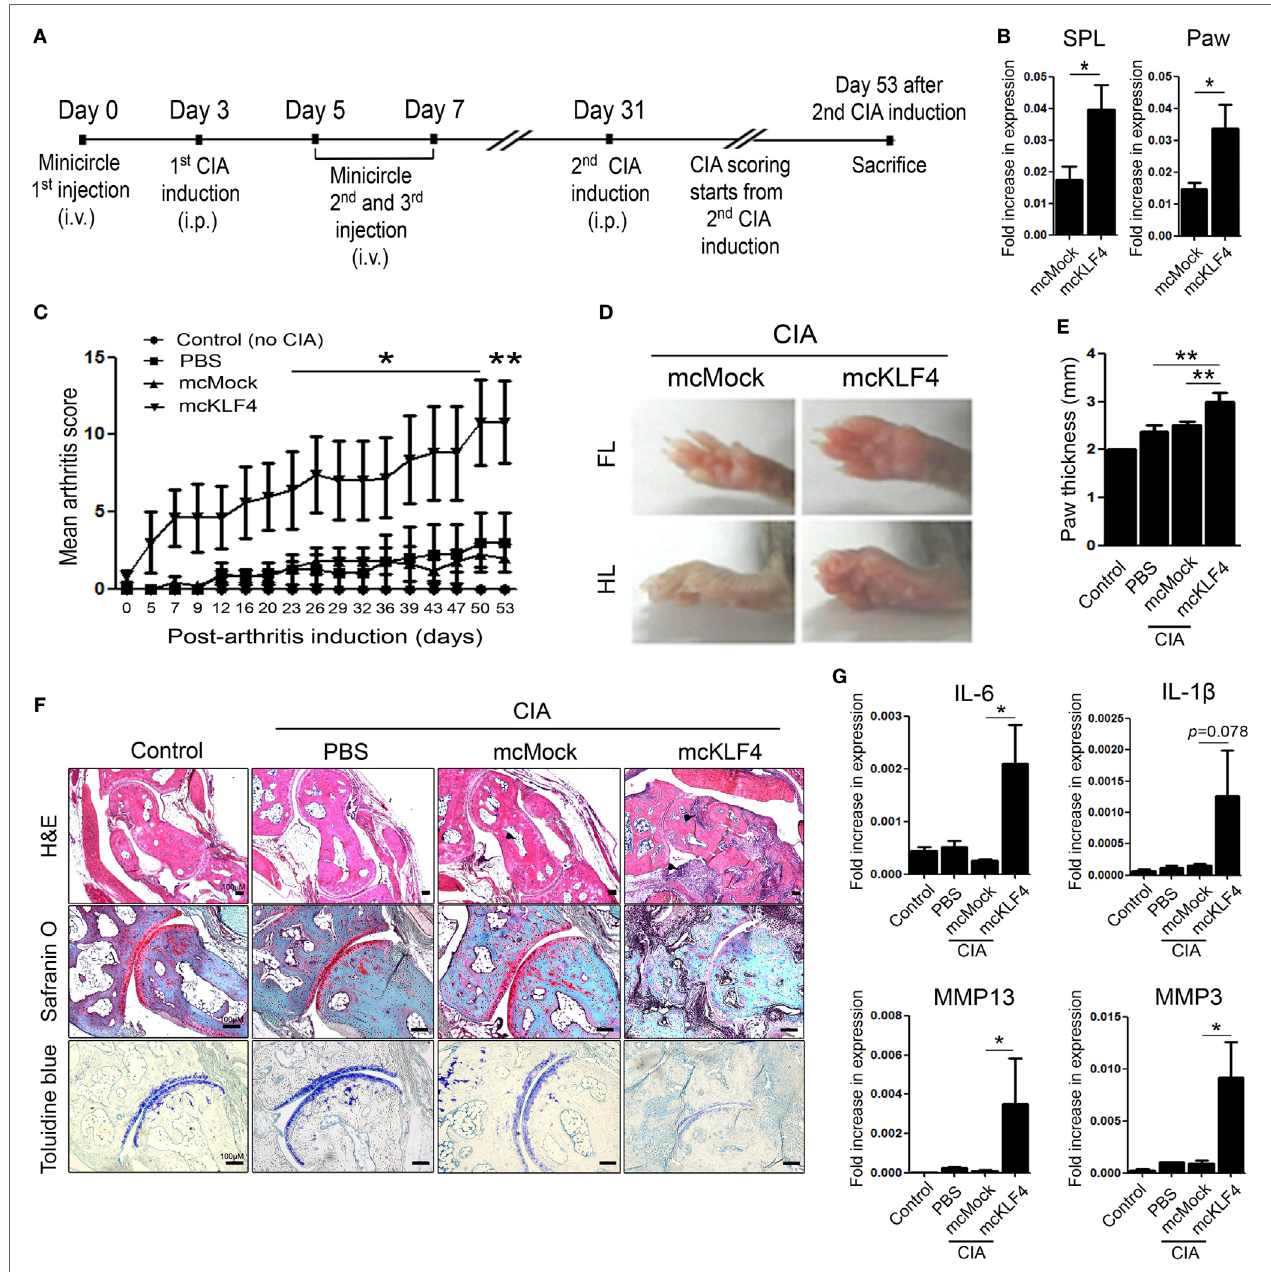
FigUre 3 | Overexpression of Kruppel-like factor (KLF) 4 in collagen-induced arthritis (CIA) mice results in severe autoimmune arthritis. (a) Experimental induction of CIA by intravenous (i.v.) injection of minicircle vectors. (b) Expression of KLF4 mRNA in splenocytes (SPL) and paw cells from minicircle Mock vector (mcMock)- and minicircle KLF4 vector (mcKLF4)-injected mouse ( n = 3). (c) Mean arthritis scores for control mice (not induced by collagen) ( n = 4), for mice induced by collagen and then i.v. injected with phosphate-buffered saline (PBS) ( n = 4), for mcMock-transduced mice ( n = 5), and for mcKLF4-transduced mice ( n = 5). (D) Hindlimbs (HLs) and paws of mcMock- and mcKLF4-injected CIA model mice. (e,F) Paw thickness and immunohistochemical staining of HLs from control and PBS-, mcMock-, and mcKLF4-injected mice. Tissues were stained as described in Figure 2e . Cellular infiltration is pointed by arrow heads. Data are representative of at least five replicates of the staining per each group. Original magnification: hematoxylin and eosin (H&E), 50 × ; Safranin O and Toluidine blue, 100 × . (g) Expression of mRNA encoding interleukin (IL)-6, IL-1 β , matrix metallopeptidase 13 (MMP13), or MMP3 in paw cells. Values in panels (b,c,e,g) are expressed as the mean ± SEM (* P < 0.05 and ** P <